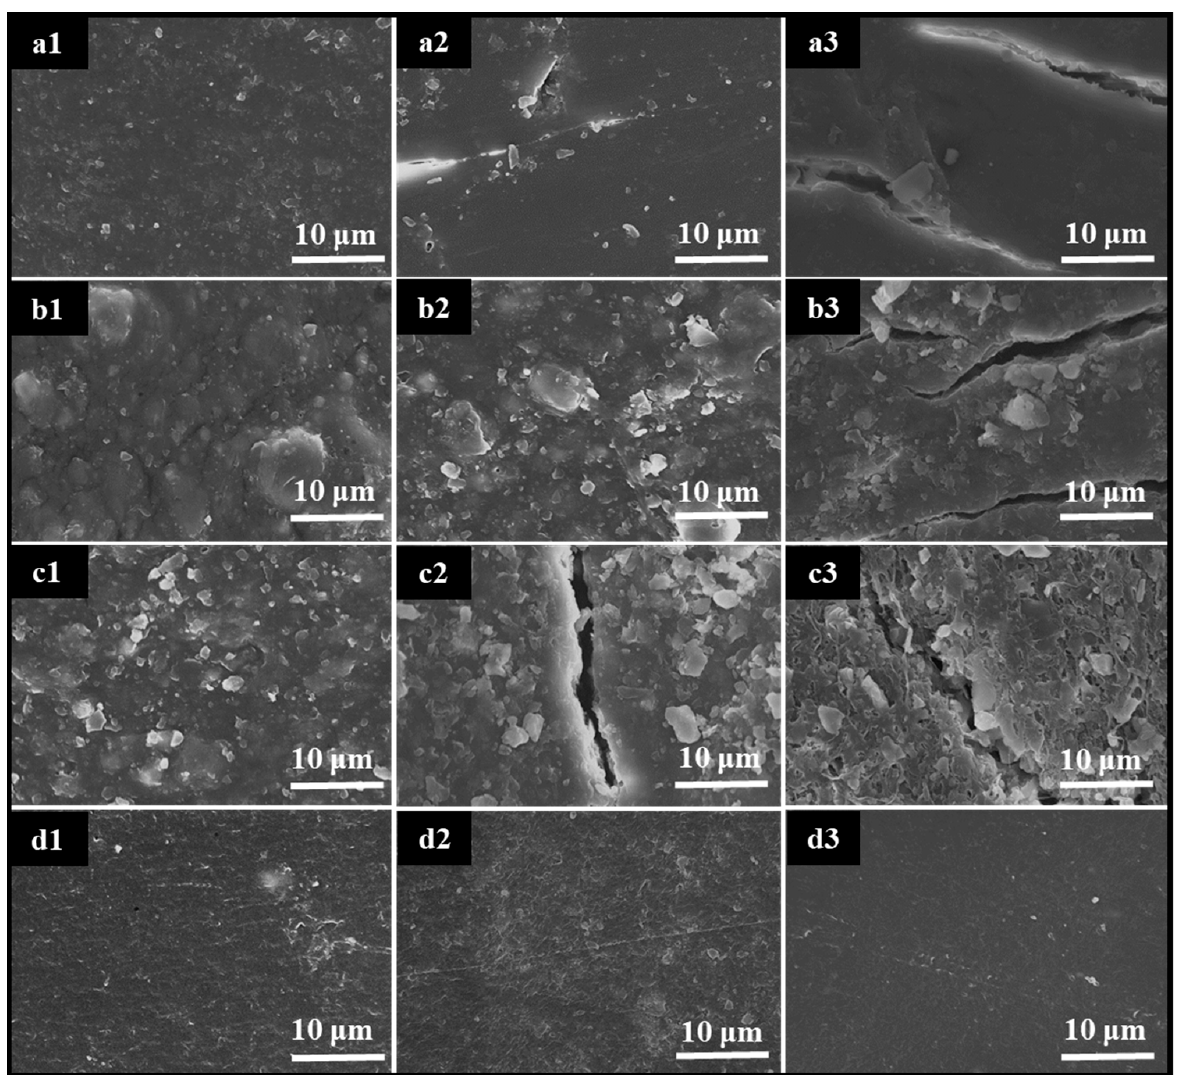
Figure 1. SEM images of BDM ( a ), BDM1 ( b ), BDM2 ( c ), and PE ( d ) after mulching at 0 ( a1 , b1 , c1 , d1 ), 87 ( a2 , b2 , c2 , d2 ), and 165 ( a3 , b3,c3 , d3 ) days.